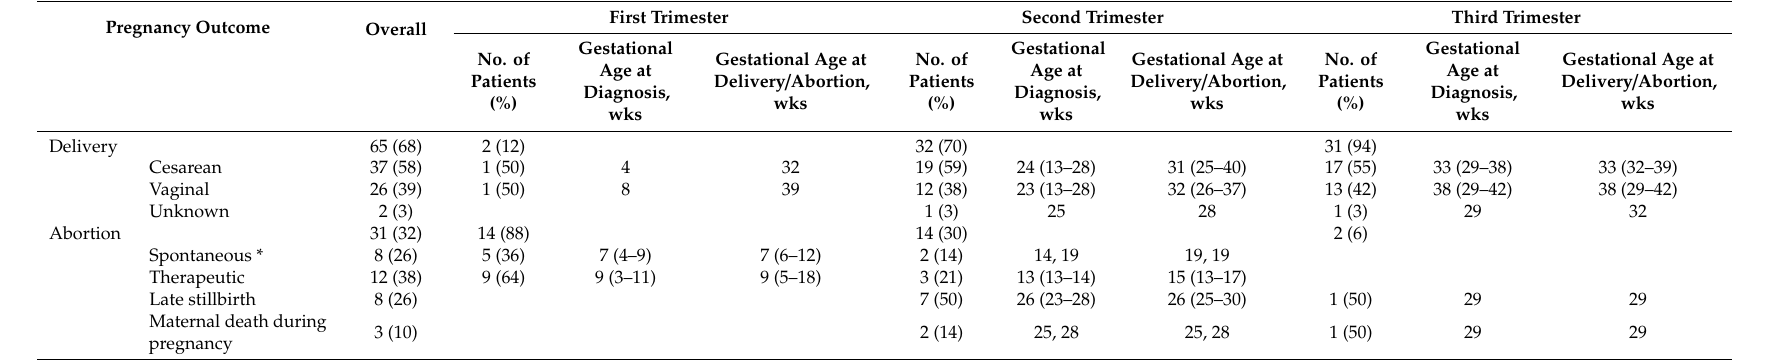
Table 4. Pregnancy outcomes by gestational age at diagnosis in pregnant women with